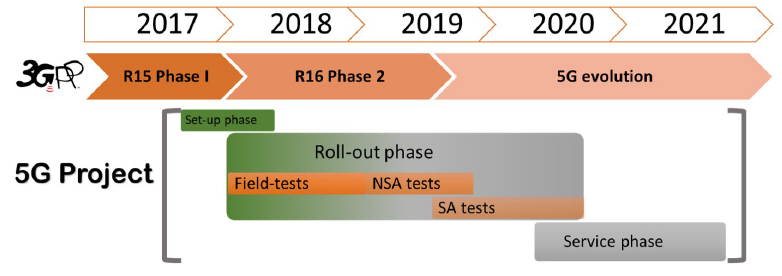
Figure 1. Project